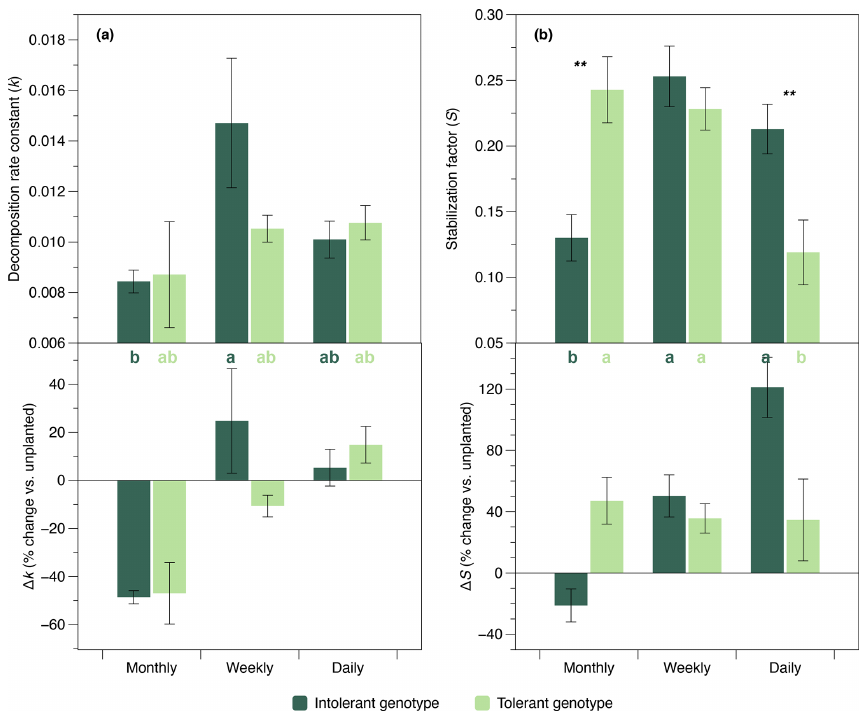
Figure 4. Initial decomposition rate constant ( k) and stabilization factor ( S ) (sensu Keuskamp et al., 2013) in soils planted with intolerant and tolerant plant genotypes of Elymus athericus exposed to three different flooding frequencies (monthly, weekly, and daily). Upper panels show absolute values, and lower panels show values in relation to the unplanted control (i.e., percentage change vs. the mean value of n = 4 unplanted mesocosms per flooding treatment). Values are means and SE ( n = 8). Asterisks denote significant genotypic differences within the same flooding treatment ( ∗ = p ≤ 0 . 05; ∗∗ p ≤ 0 . 01). Bars not labeled by the same letter are significantly different at p ≤ 0 . 05. All statistical results refer to the absolute data shown in the upper panels and are based on Tukey’s HSD tests following two-way ANOVA for S and Kruskal–Wallis tests for k